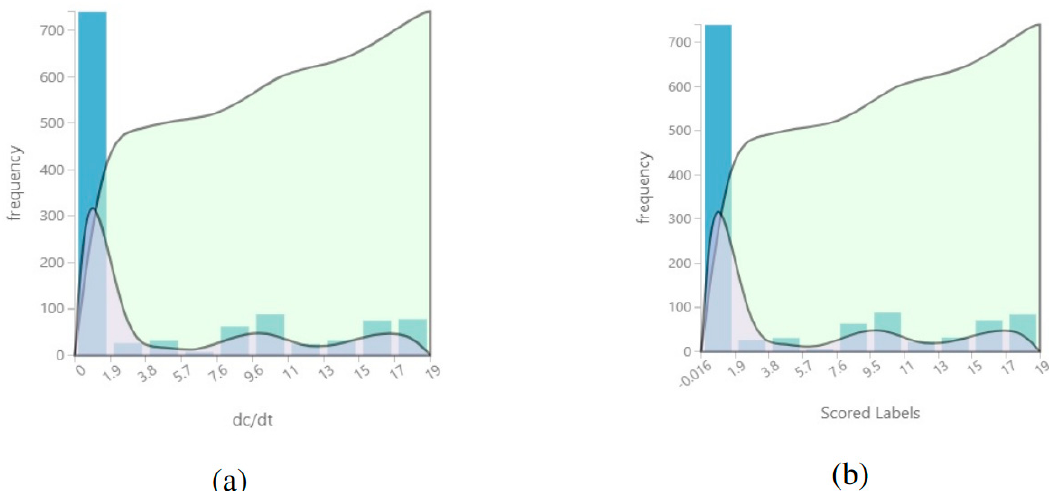
Figure 3. Histogram (blue), cumulative distribution function (green) and probability density function (purple) for ( a ) the actual values of the dc / dt and ( b ) the predicted values of the dc / dt for the pilot dataset with all the features included.